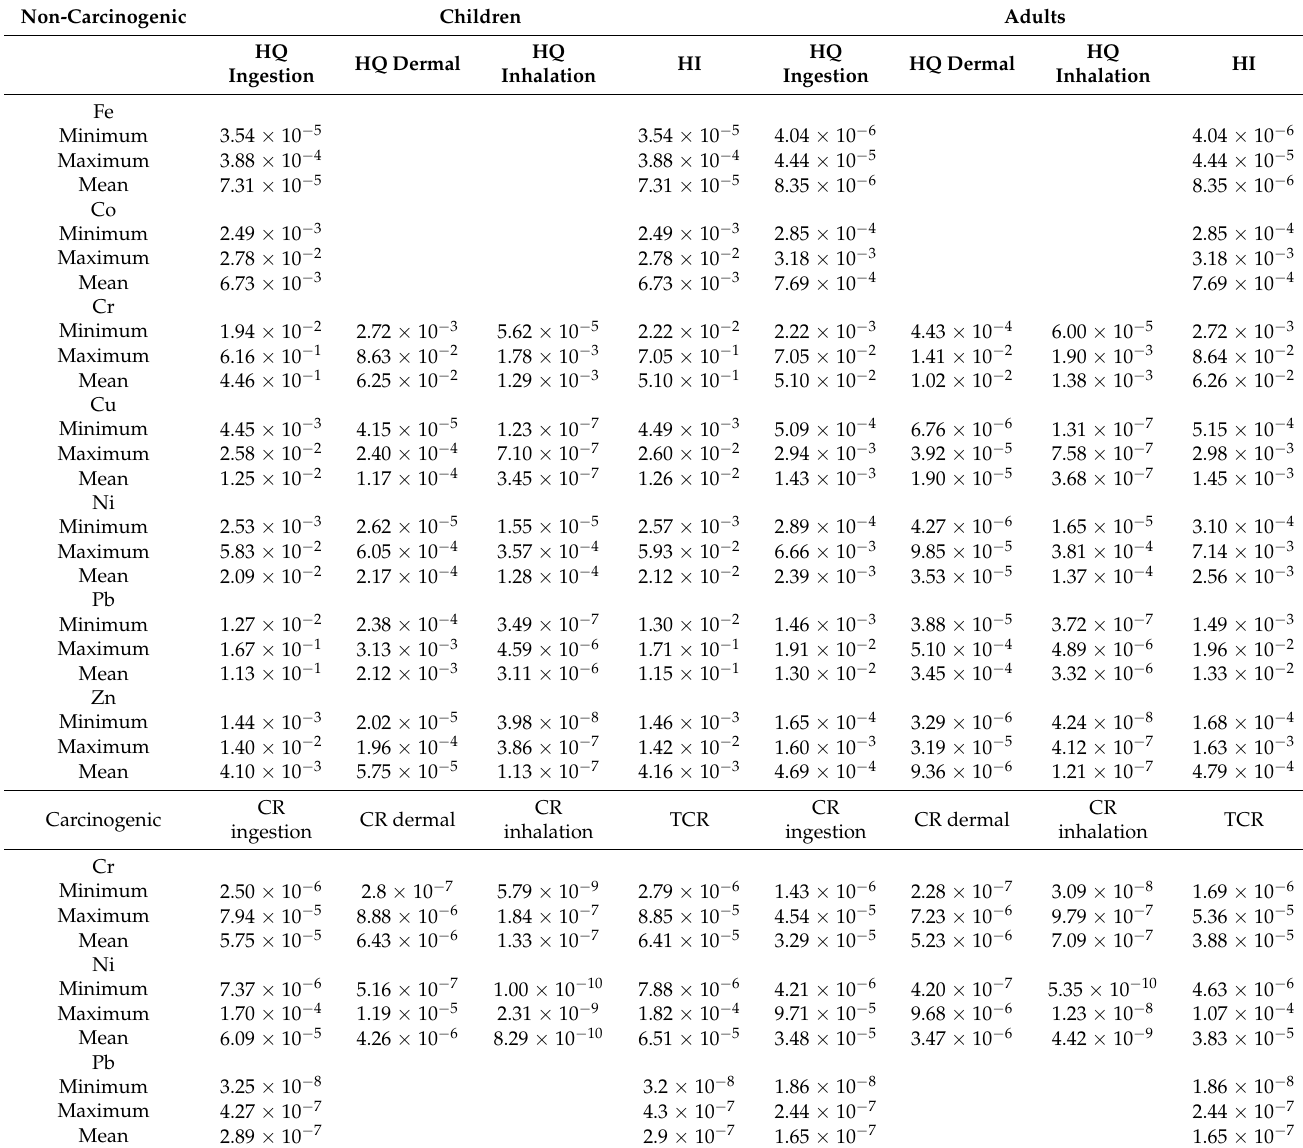
Table 3. Non-carcinogenic and carcinogenic risks through ingestion, inhalation and dermal pathways for children and adults based on selected trace metals in geophagic clays from